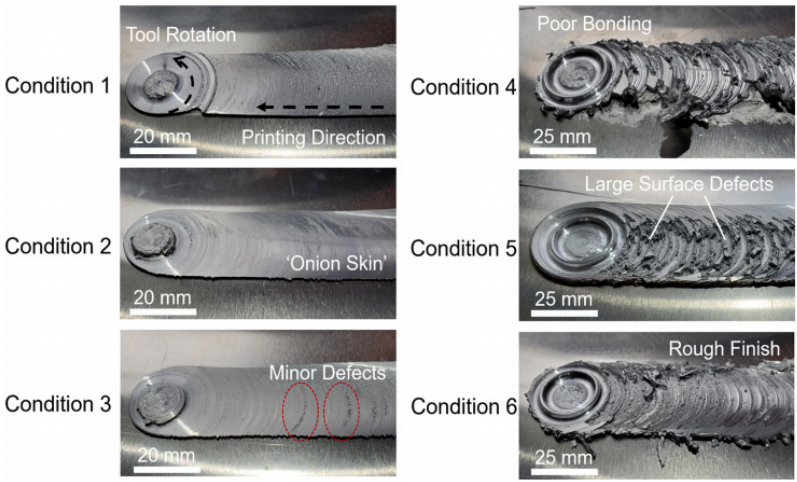
Figure 8. The surface quality of Al-Mg-Si under different conditions. Flat tool: conditions 1~3; Protruding tool: conditions 4~6 [33].